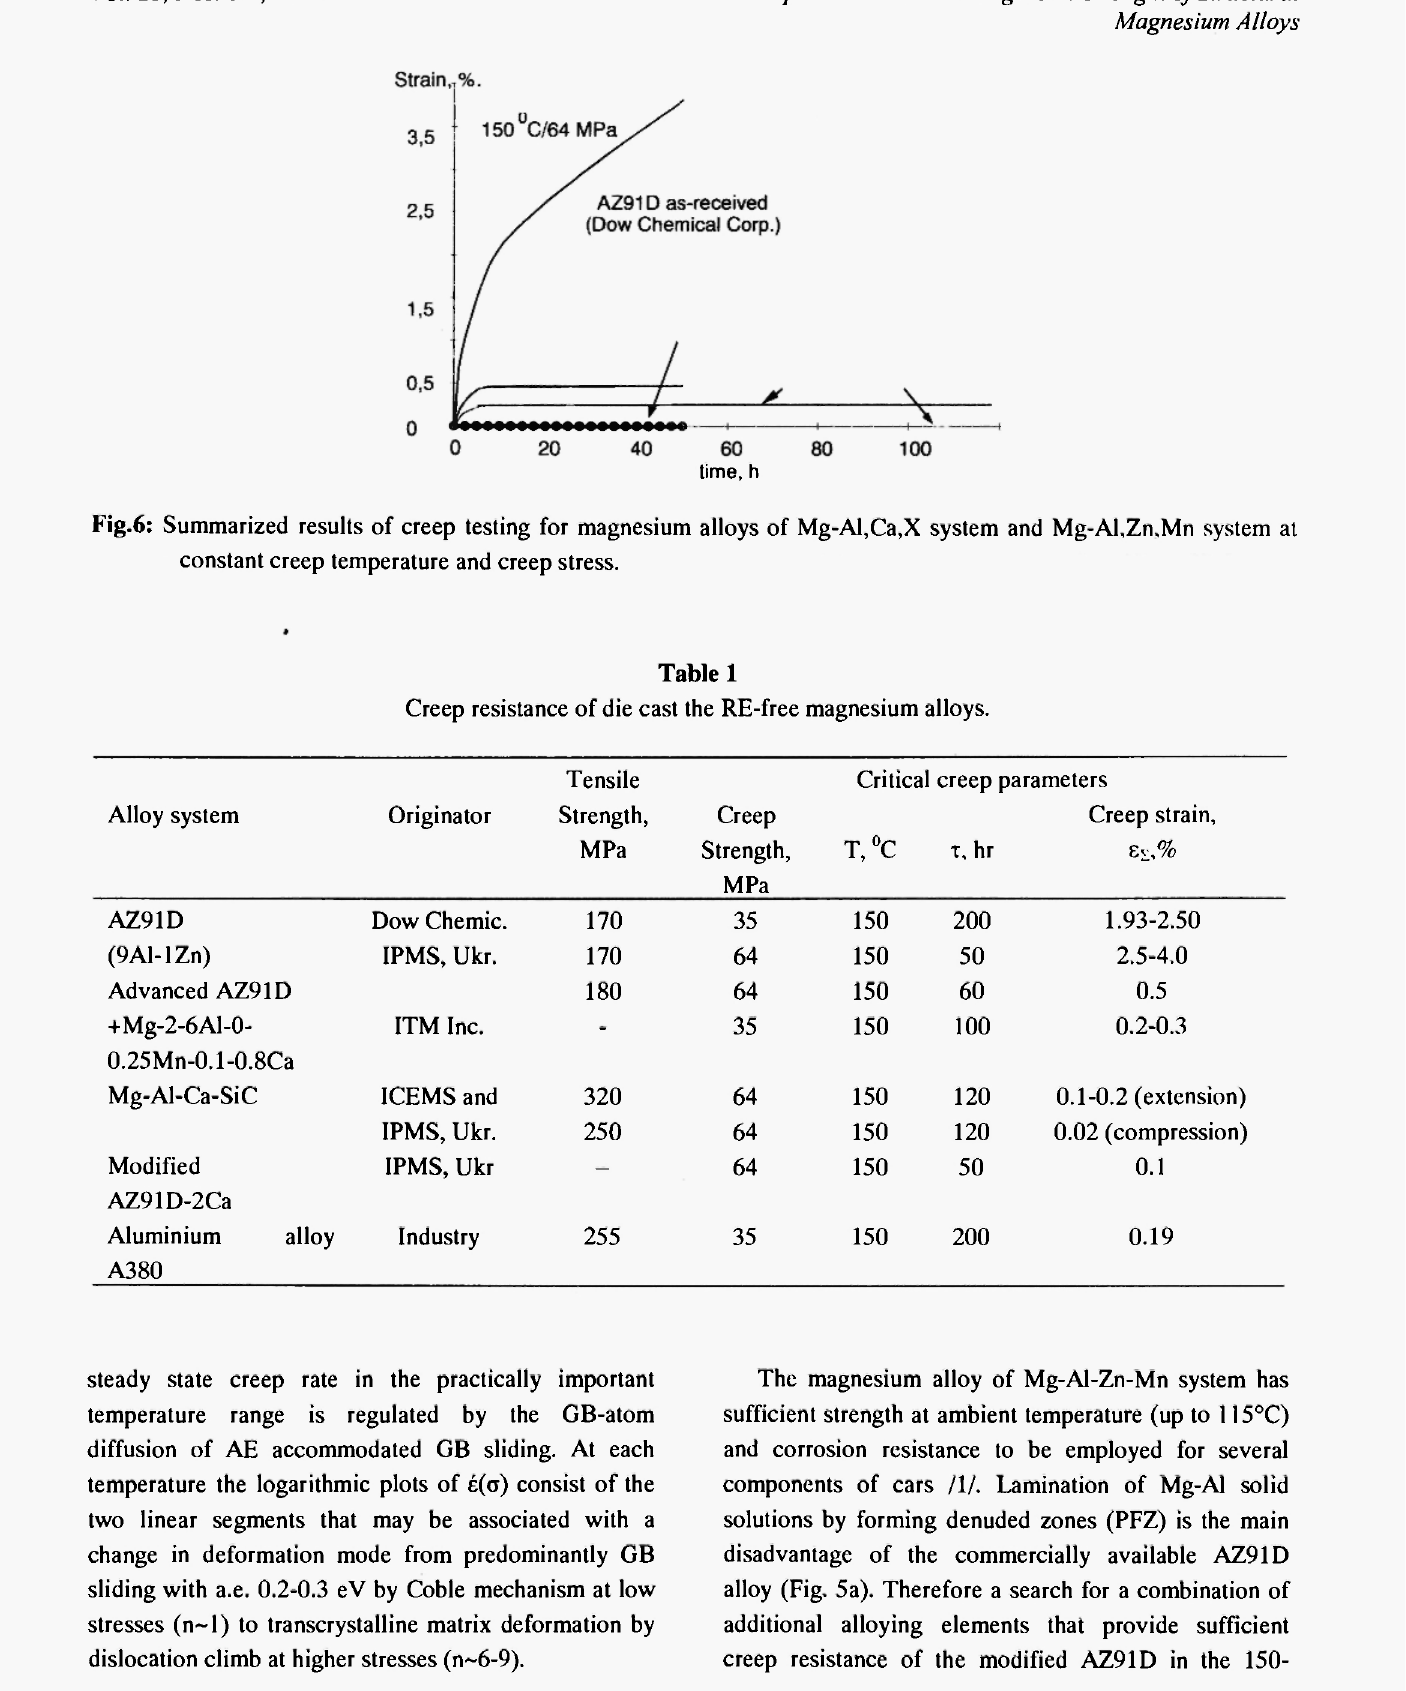
Fig .6: Summarized results of creep testing for magnesium alloys of Mg-Al,Ca,X system and Mg-Al,Zn,Mn system at constant creep temperature and creep stress.